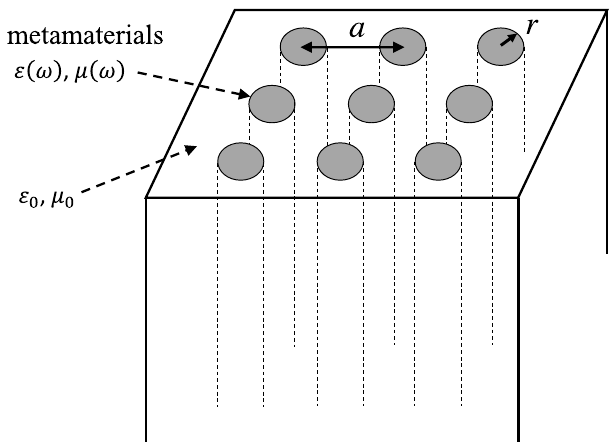
Fig. 1. Schematic illustration of 2DMPC with array of